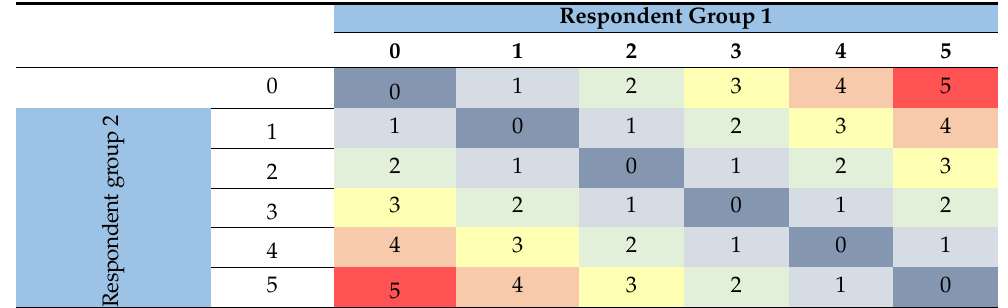
Table 1. All theoretical possibilities of combinations of cross-tabulated values to determine the absolute difference.